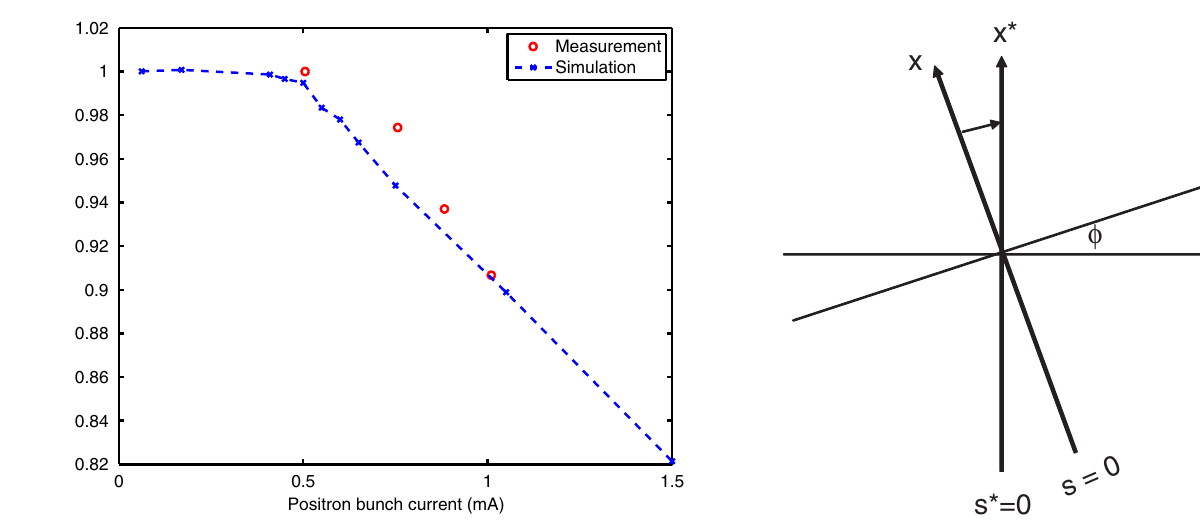
FIG. 6. (Color) Ratio of hadron events to Bhabha was measured as a function of positron bunch current using the Belle detector. The data is normalized to the measured value at 0.5 mA. The result of simulation is plotted according to Eq. (18) and the energy spreads at zero currents are used for the